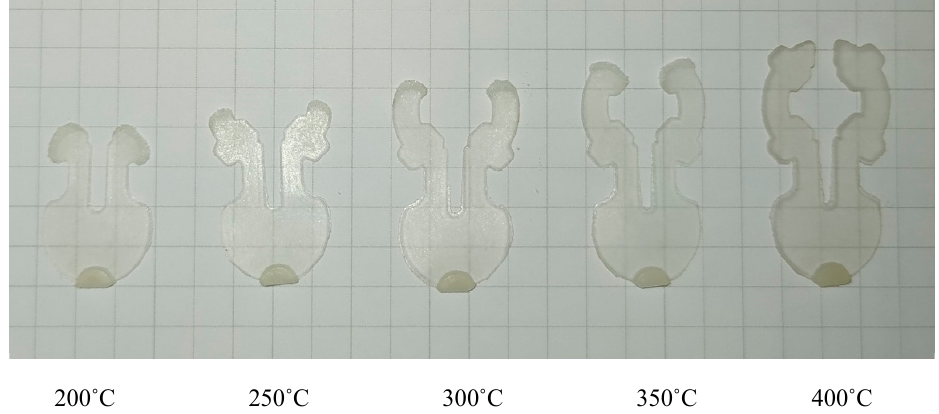
Figure 19. The melt flow length of front cover part after molding with the In-GMTC under different hot-gas temperatures.